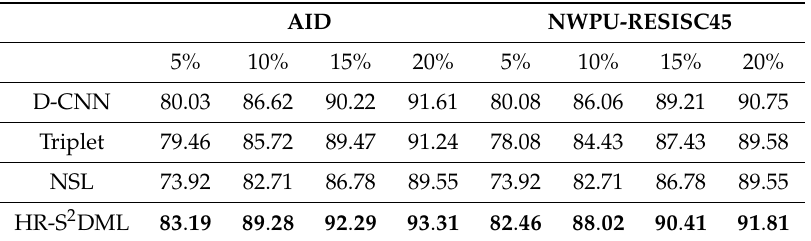
Table 1. K NN classification accuracies (%) obtained by using the considered methods, when the percentages of the labeled images are 5%, 10%, 15%, and 20%, respectively, and K = 10. AID